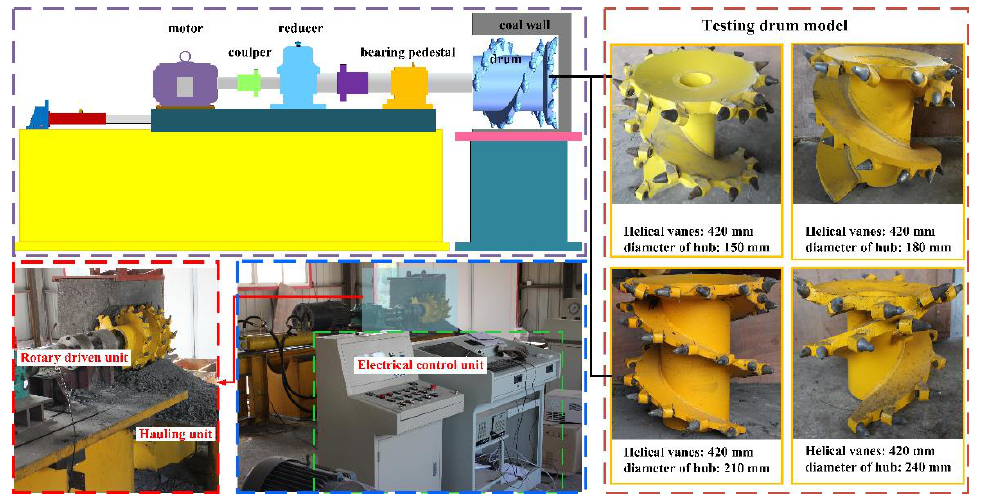
Figure 9. Coal-loading test bench.